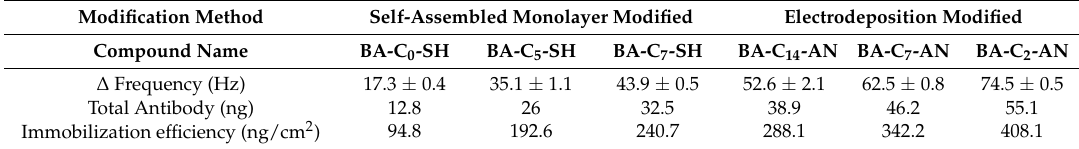
Table 2. Antibody capacity of a BA-modified QCM chip for the SAM and electrodeposition methods.